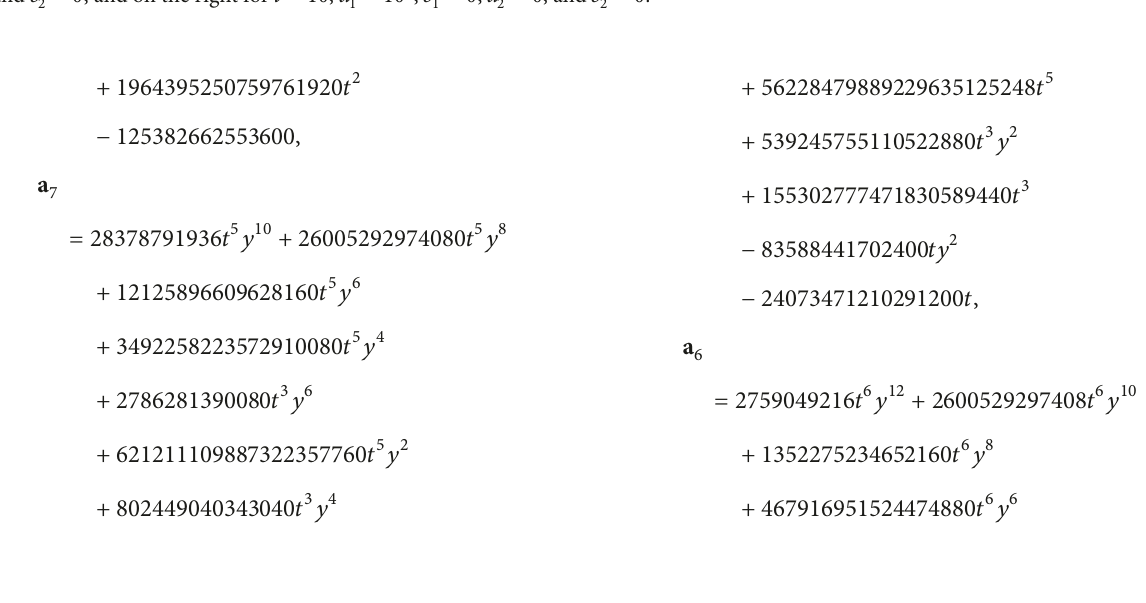
Figure 4: Solution of order 3 to (1), on the left for 𝑡 = 0, 1 , 𝑎 1 = 0 , 𝑏 1 = 0 , 𝑎 2 = 10 6 , and 𝑏 2 = 0 ; in the center for 𝑡 = 1 , 𝑎 1 = 0 , 𝑏 1 = 0 , 𝑎 2 = 10 6 , and 𝑏 2 = 0 ; and on the right for 𝑡 = 10 , 𝑎 1 = 10 3 , 𝑏 1 = 0 , 𝑎 2 = 0 , and 𝑏 2 = 0 .